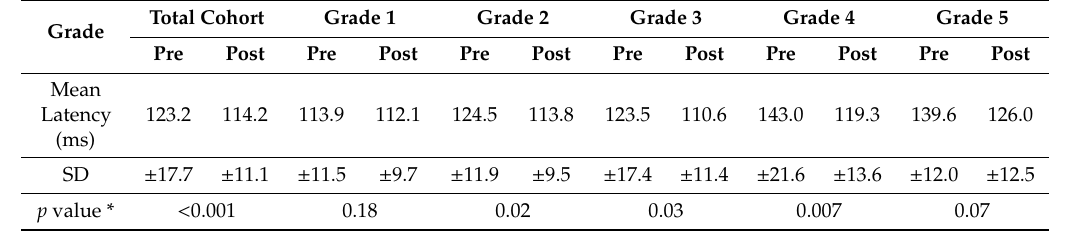
Table 3. Pre- to post-operative changes in pVEP latency for total cohort and di ff erent grades within 6 months after surgery. Decreased latency indicates Table 3 . Pre- to post-operative changes in pVEP latency for total cohort and different grades within 6 months after surgery. Decreased latency indicates improvement.